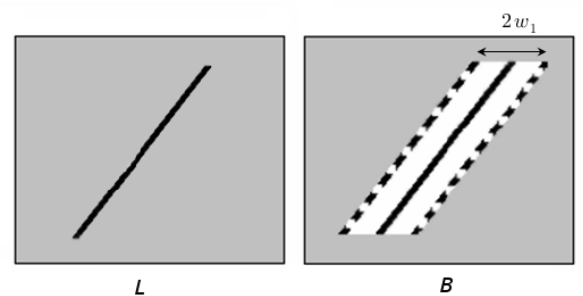
Fig. 7. Left: 2-dimensional array L with the line corresponding to Fig. 07. Left: 2-dimensional array L with the line corresponding to contrail C . Right: 2-dimensional array B with the area (white) in contrail C . Right: 2-dimensional array B with the area (white) in which contrail C(t + 1t) is expected to be which contrail C ( t + ∆ t ) is expected to be found.